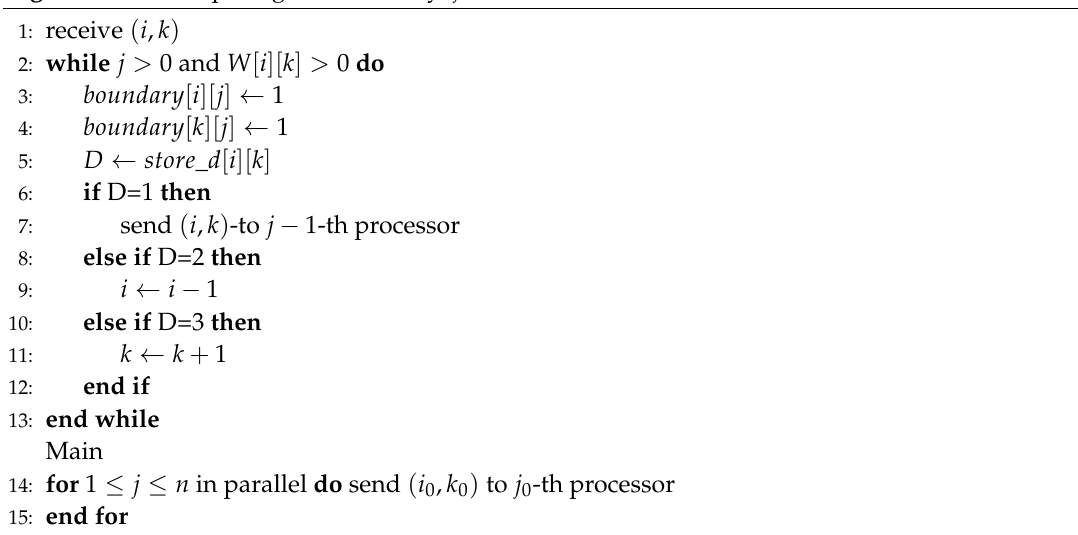
Algorithm 12 Computing the boundary; j -th